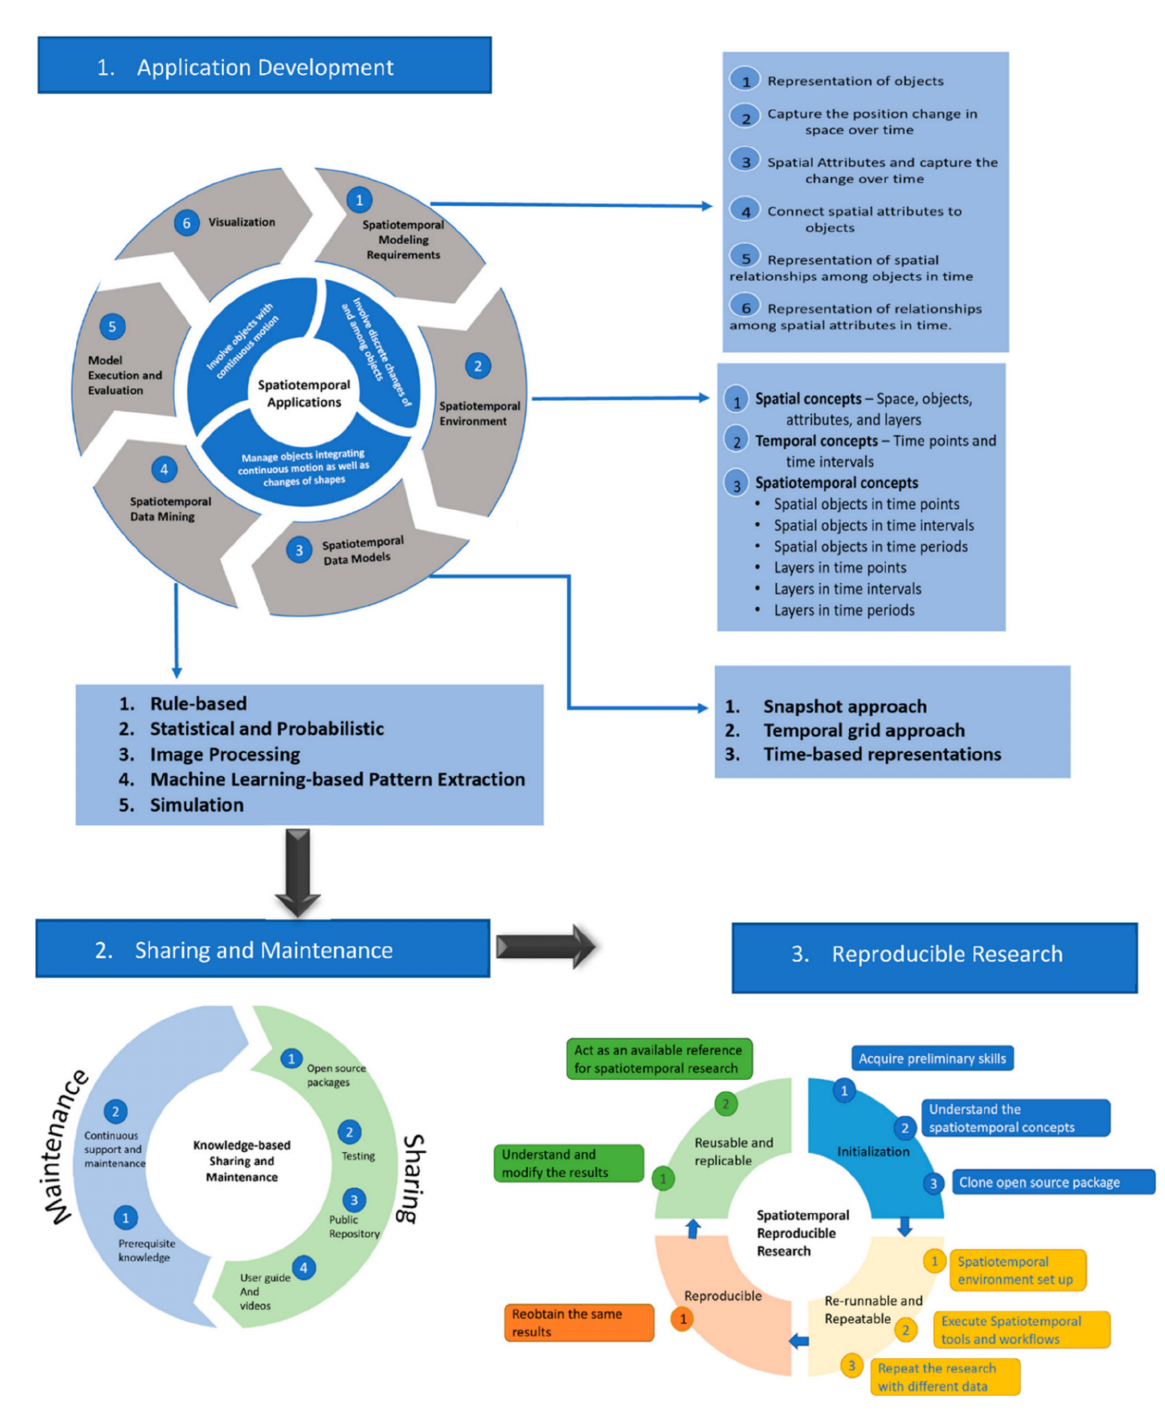
Figure 1. Open source workflow for spatiotemporal